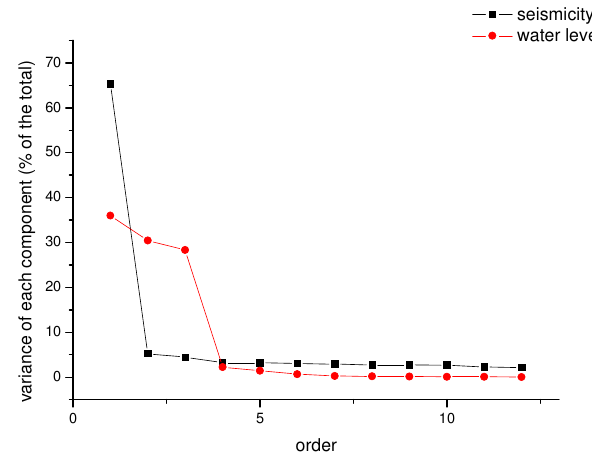
Fig. 5. Variance λ k of each component of the investigated time se- ries as percentage of the total